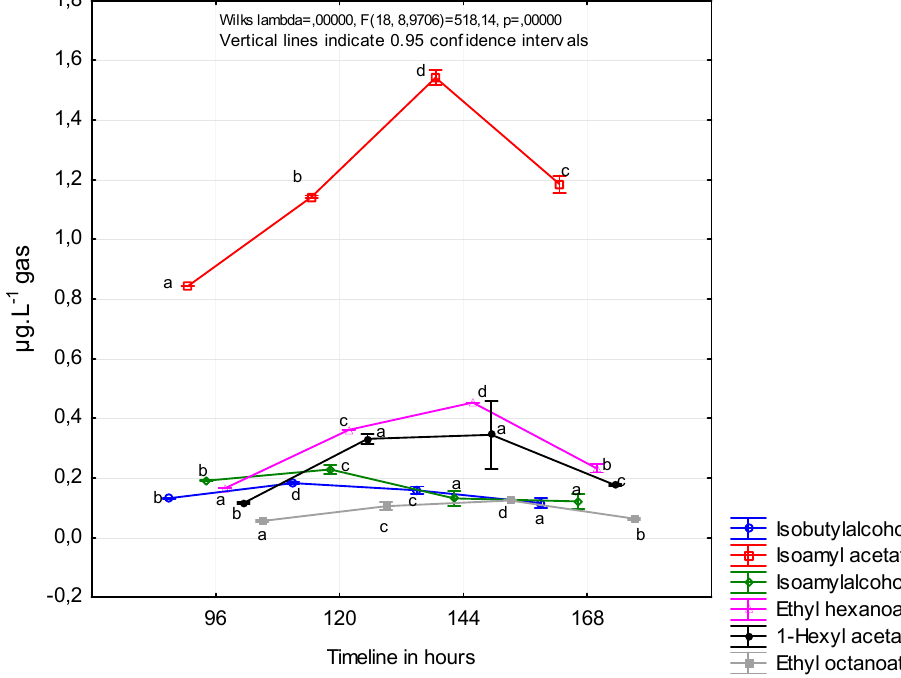
Figure 2. The concentrations of the individual volatile substances contained in the fermentation gas. The division into homogeneous groups (a,b,c,d) was based on the least significant difference (LSD) test, the significance level is α = 0.005.